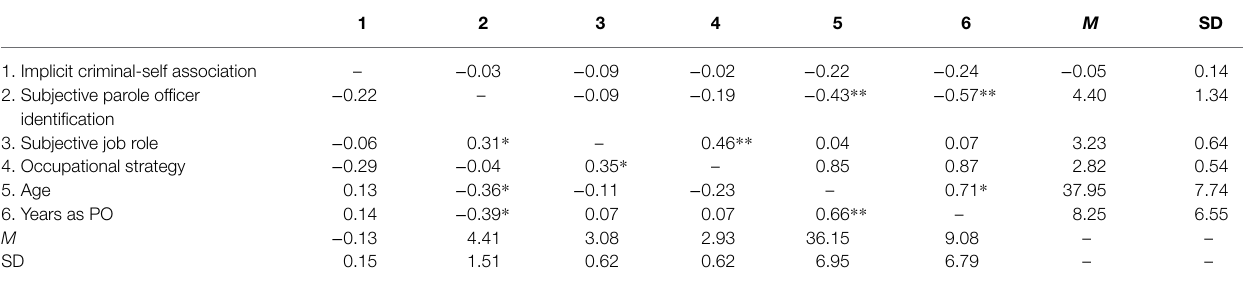
TABLE 3 | Zero-order correlations and descriptives by experience